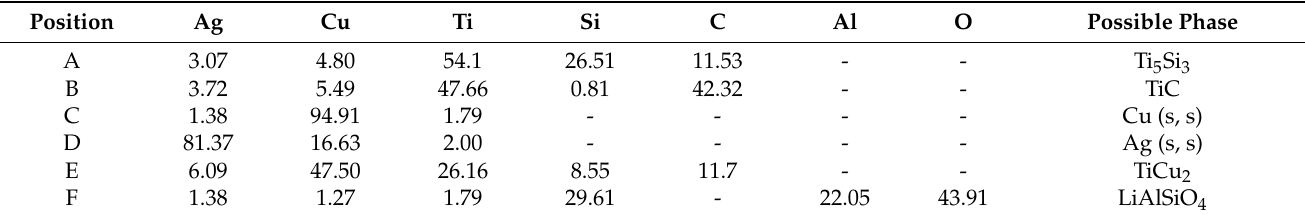
Table 2. The EDS analysis results of the various phases in the joint shown in Figure 4b (at. %).